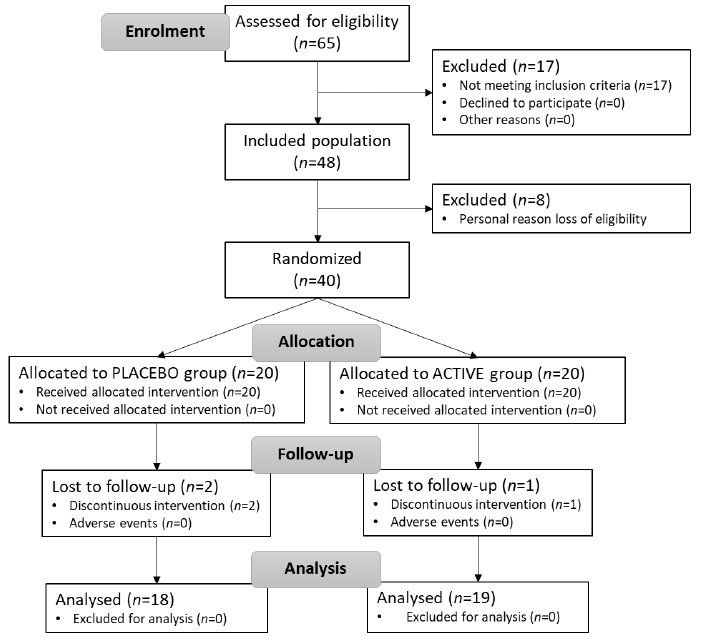
Figure 1. CONSORT subject flow diagram (PLACEBO group = control; ACTIVE group = probiotics– elderberry supplementation).